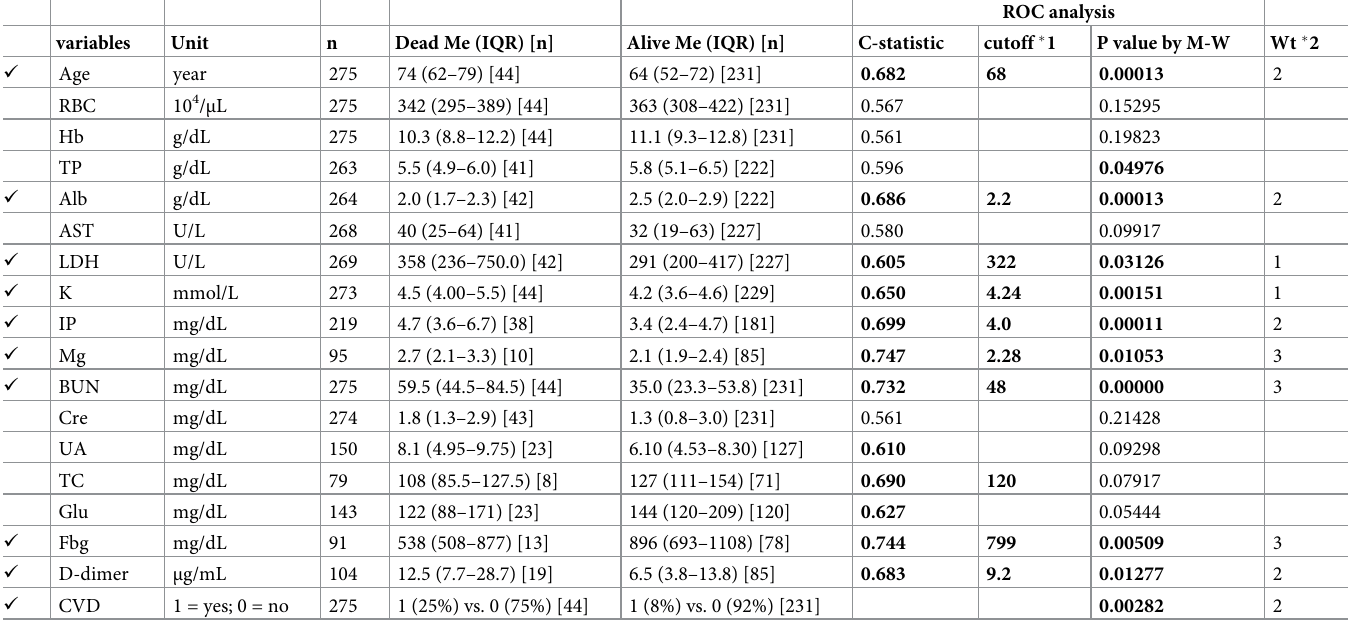
Table 1. Univariate comparison of laboratory data according to the outcome (dead/alive) at 72